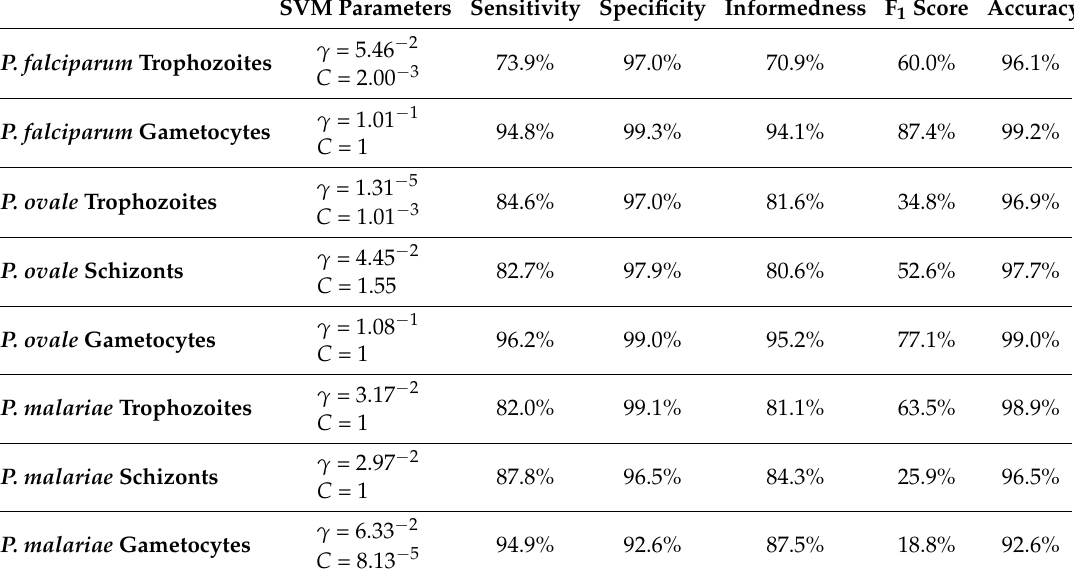
Table 5. Results after machine learning classification for each species-stage